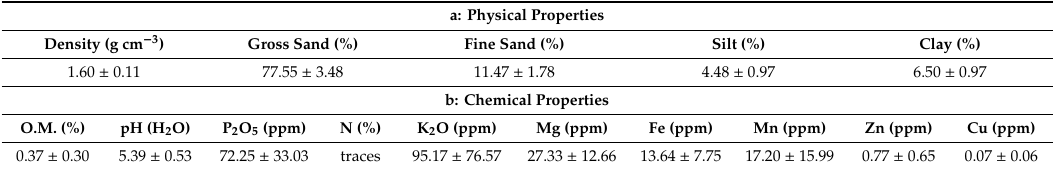
Table 1. Main results (Mean ± SD) of the physical ( a ) and chemical ( b ) properties of the soil profile at eight experimental field locations.